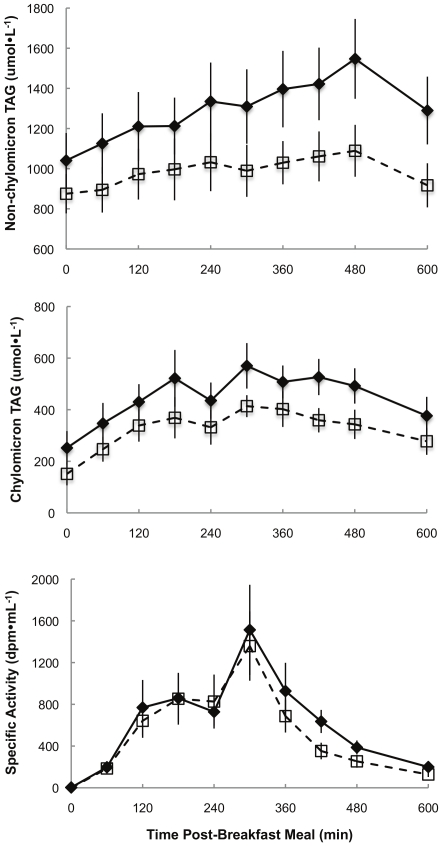
Daytime plasma triglyceride concentrations and specific activity.Plasma non-chylomicron (top panel) and chylomicron triglyceride concentrations (middle panel) and chylomicron triglyceride specific activity (lower panel) during the first 10 h of the experimental meal day. ♦,—represents T(+) men, □, - - -represents T(−) men. There were no differences between groups across time for chylomicron triglyceride concentrations and SA. Non-chylomicron triglycerides were greater (p = 0.02) in T(+) men across time.